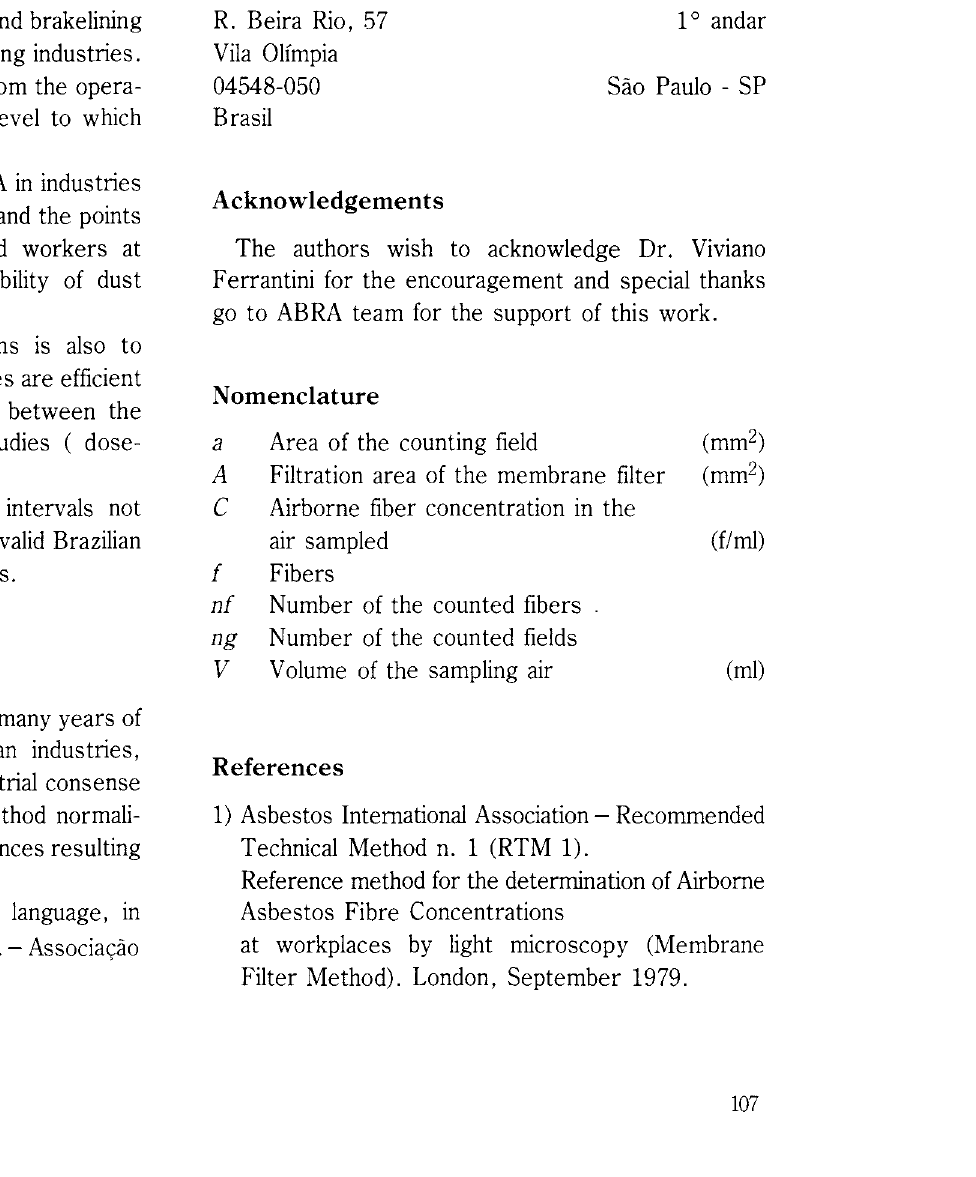
Fig. 2 Level of airborne chrysotile asbestos fiber concentration evolution in the asbestos cement